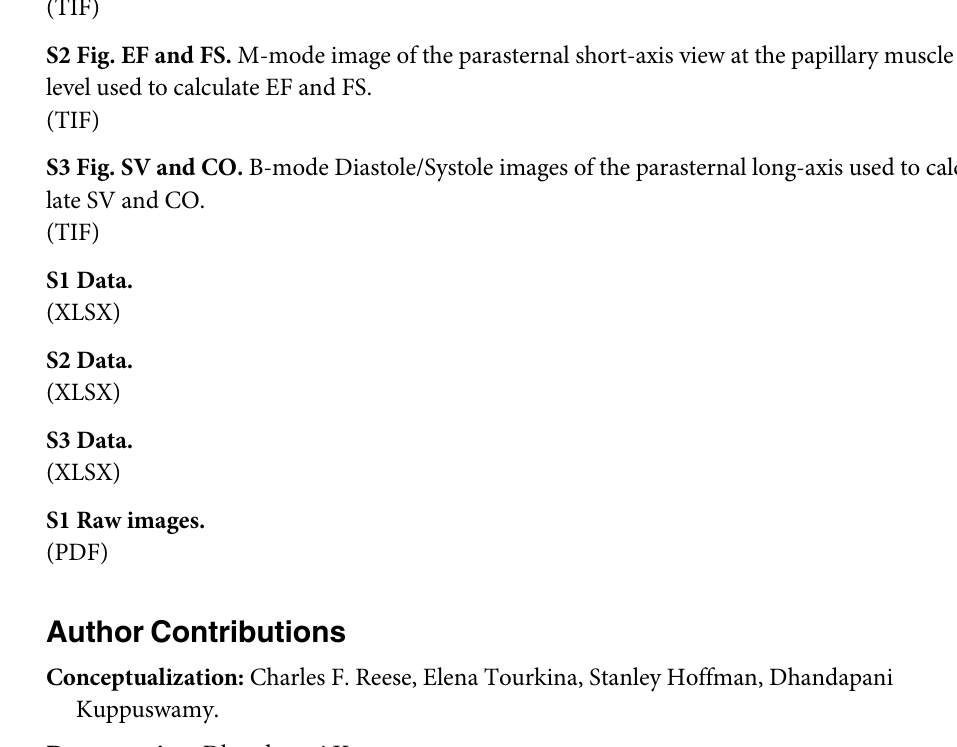
S1 Fig. IVRT. Tissue Doppler was used in the short-axis view at the papillary muscle level to calculate IVRT. S2 Fig. EF and FS. M-mode image of the parasternal short-axis view at the papillary muscle level used to calculate EF and FS. S3 Fig. SV and CO. B-mode Diastole/Systole images of the parasternal long-axis used to calcu- late SV and